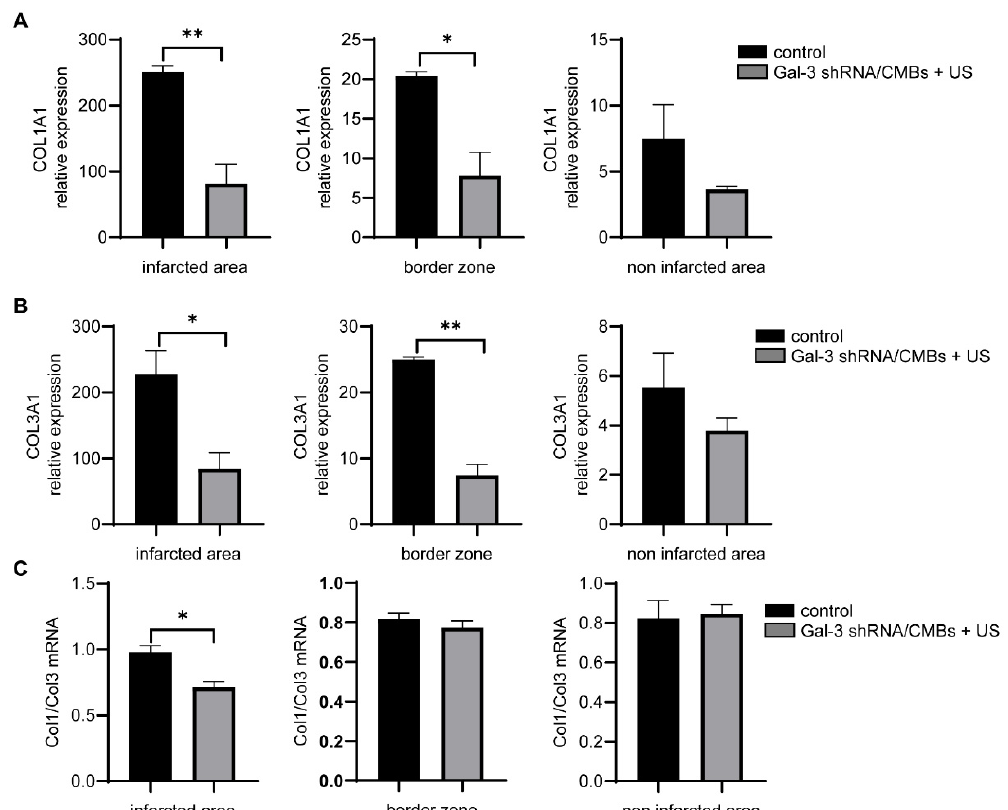
Figure 6. Collagen synthesis in MI rats. ( A ) COL1A1 mRNA expression in different regions of MI heart. ( B ) COL3A1 mRNA expression in different regions of MI heart. ( C ) Ratio of Col1/Col3 mRNA expression in different regions of MI heart ( n = 3, * p < 0.05, ** p < 0.01).